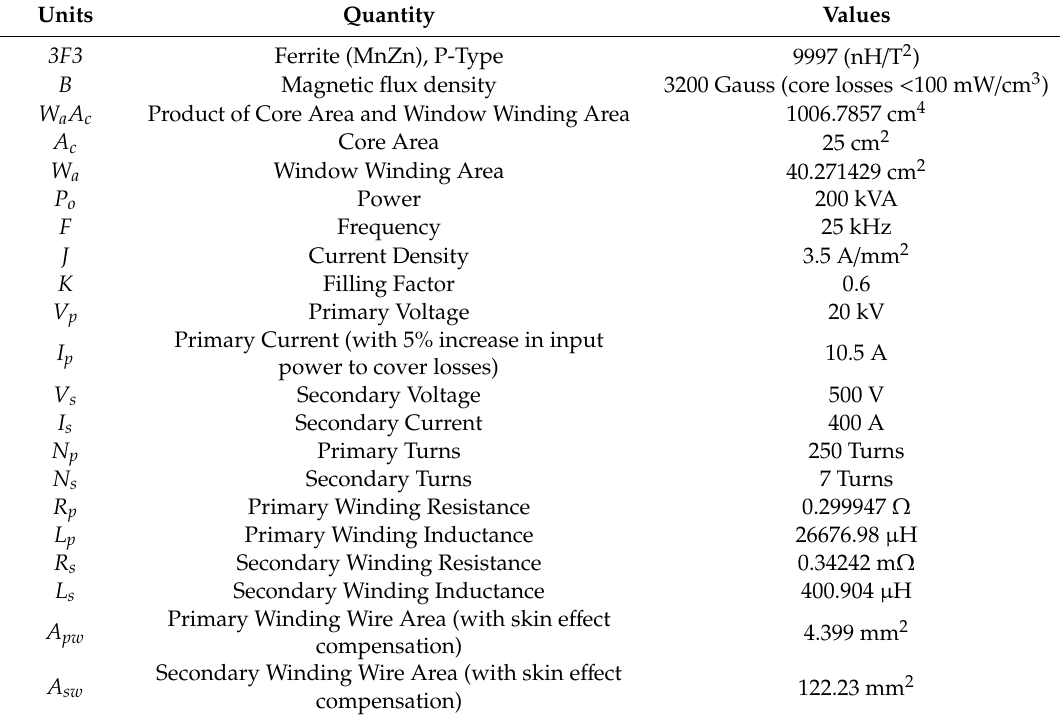
Table 4. Parameters of a high frequency ferrite